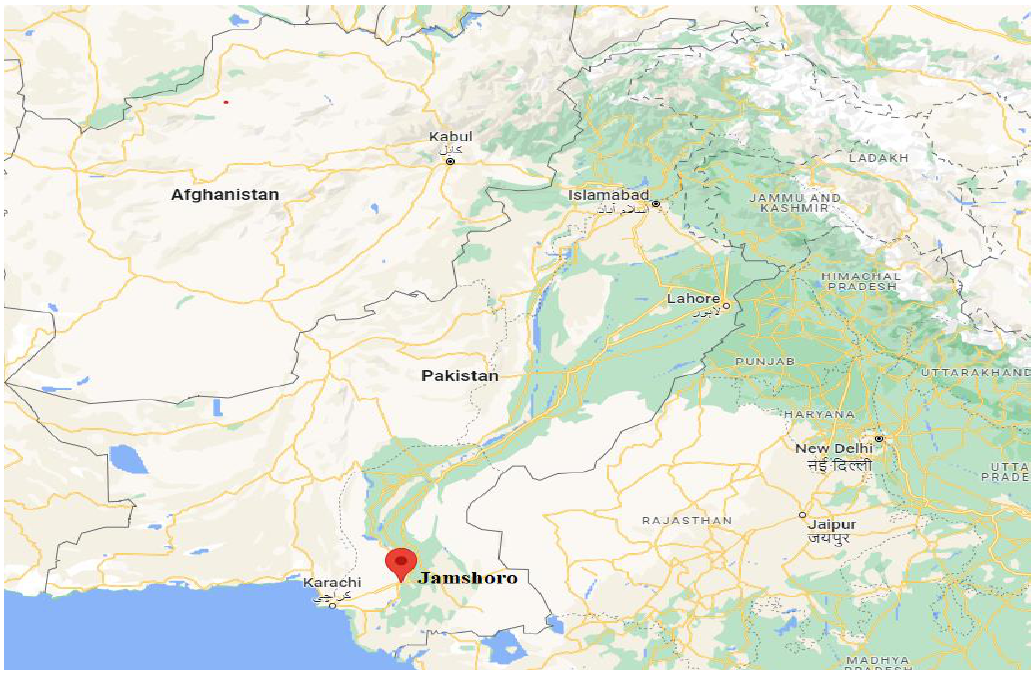
Figure 2. Satellite view of Jamshoro [42]. Table 1. Input parameters.